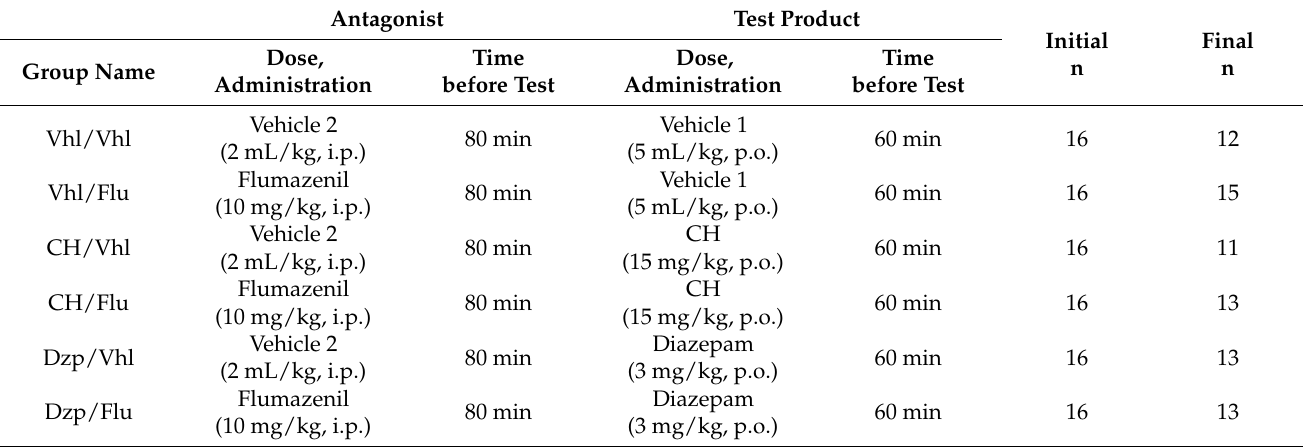
Table 1. Summary of the tested products, used doses, ways of administration, time of administration before testing and names of experimental groups analyzing the involvement of the benzodiazepine site of GABA A receptors in the anxiolytic activity of CH. Rats that did not touch the probe were removed from the experiment (final n compared to initial n). Vehicle 1 corresponds to the solution for the suspension of diazepam and vehicle 2 to that for the suspension of flumazenil. Antagonist Test Product